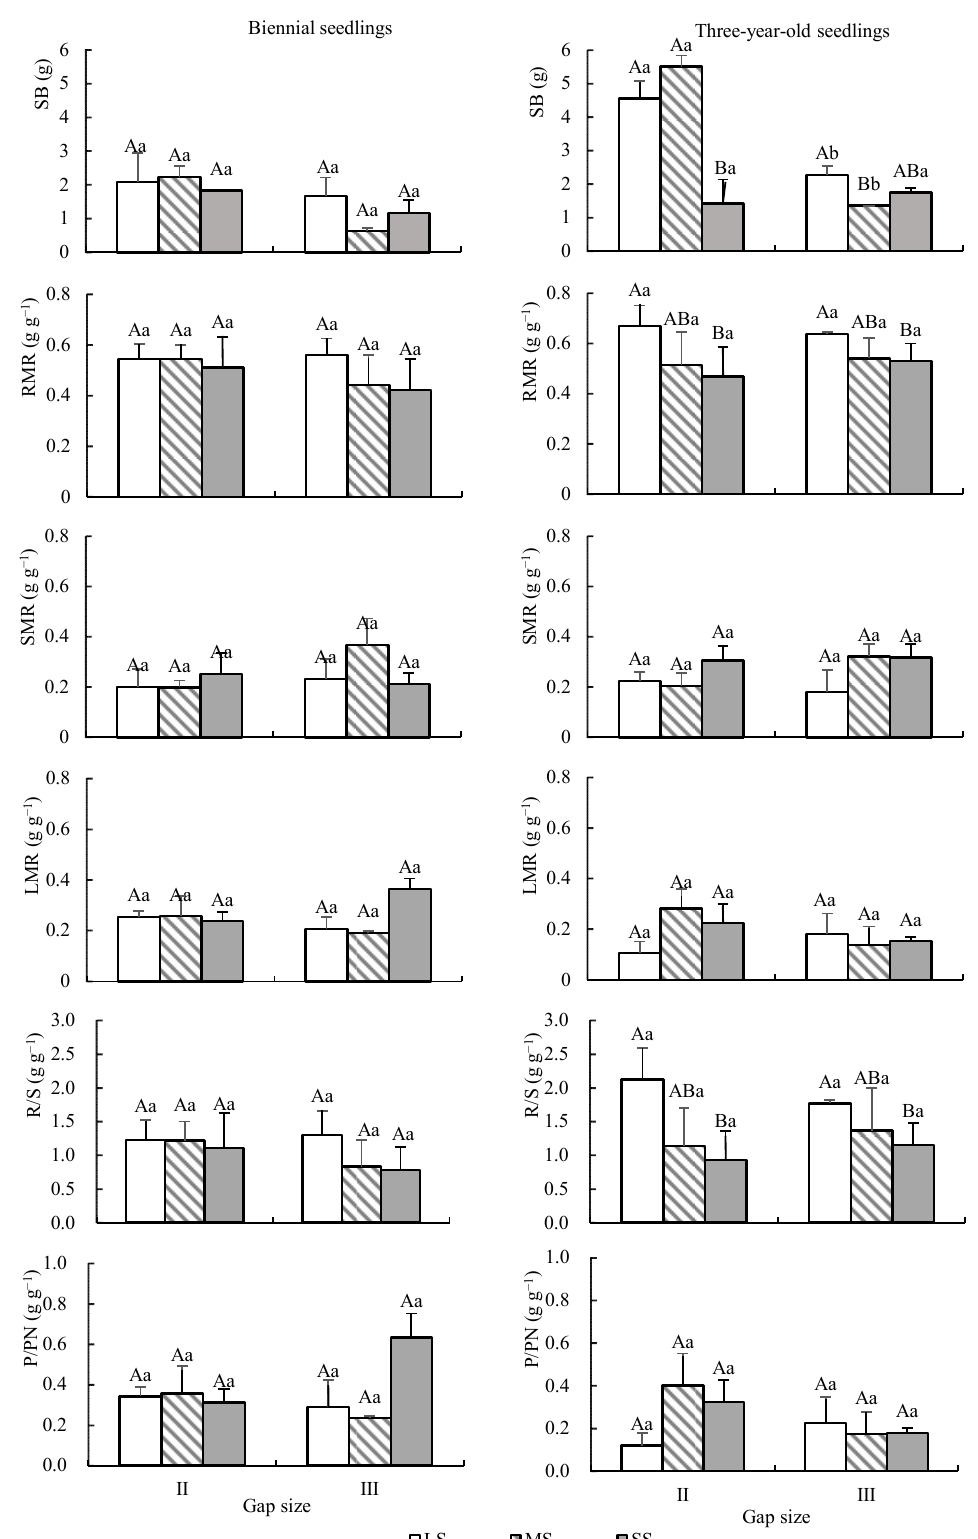
Figure 6. Dynamic changes of biomass and biomass allocation of Quercus acutissima seedlings from different sizes of seeds under different forest gaps. LS: large seed; MS: medium seed; SS: small seed. Different capital letters indicate that there is a significant difference between different seed size groups under the same gap ( p < 0.05); different lower letters indicate that there is a significant difference between gaps under the same seed size ( p <